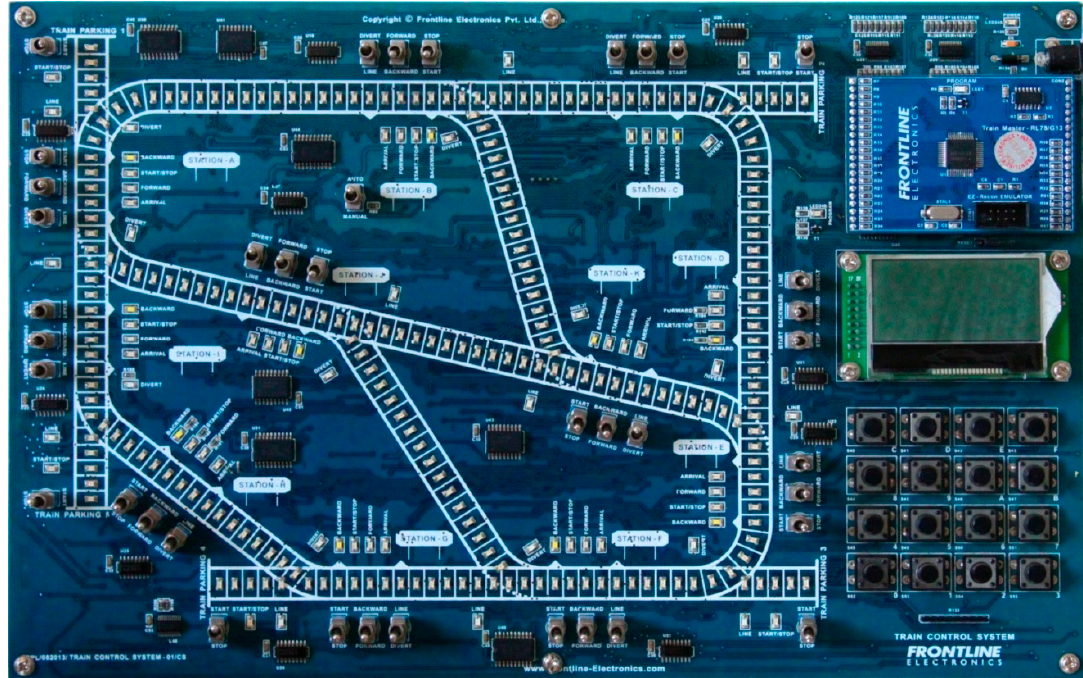
Figure 1. Hardware of the Rail-Network Simulator.